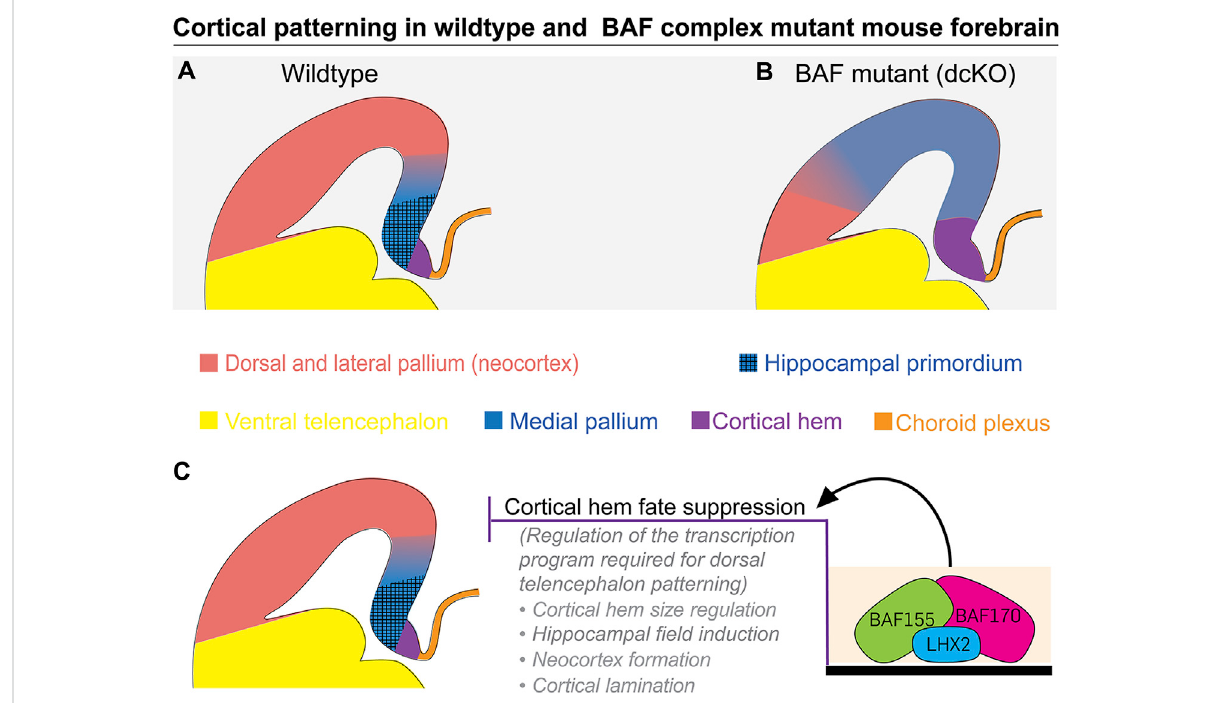
FIGURE 6 Schema depicting how dorsal telencephalon patterning is perturbed by BAF complex mutagenesis. (A) Illustration shows normal regional designation of the dorsal telencephalon (in wild type). The cortical hem, hippocampus, medial cortex/pallium, and neocortex are properly speci fi ed and placed in the wild-type dorsal telencephalon. (B) Cartoon depicting disturbance of cortical patterning due to lack of BAF complex in the dorsal telencephalic neuroepithelium (in dcKO_Emx1-Cre ). The hem and medial cortex are seen expanded at the expense of the hippocampus and neocortex, making the dcKO_Emx1-Cre dorsal telencephalon have predominance of medial cortex identity. The choroid plexus is not observably affected by BAF complex ablation. (C) A putative mechanism involving the interaction between the scaffolding BAF complex subunits BAF155 and BAF170, and the transcription factor LHX2 is put forward as a previously unknown regulatory system for driving proper cortical hem formation and patterning of the dorsal